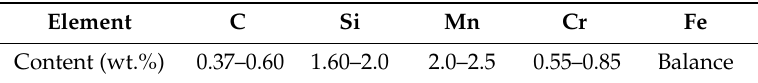
Table 1. Chemical composition of the 0.4C-Si-Mn-Cr